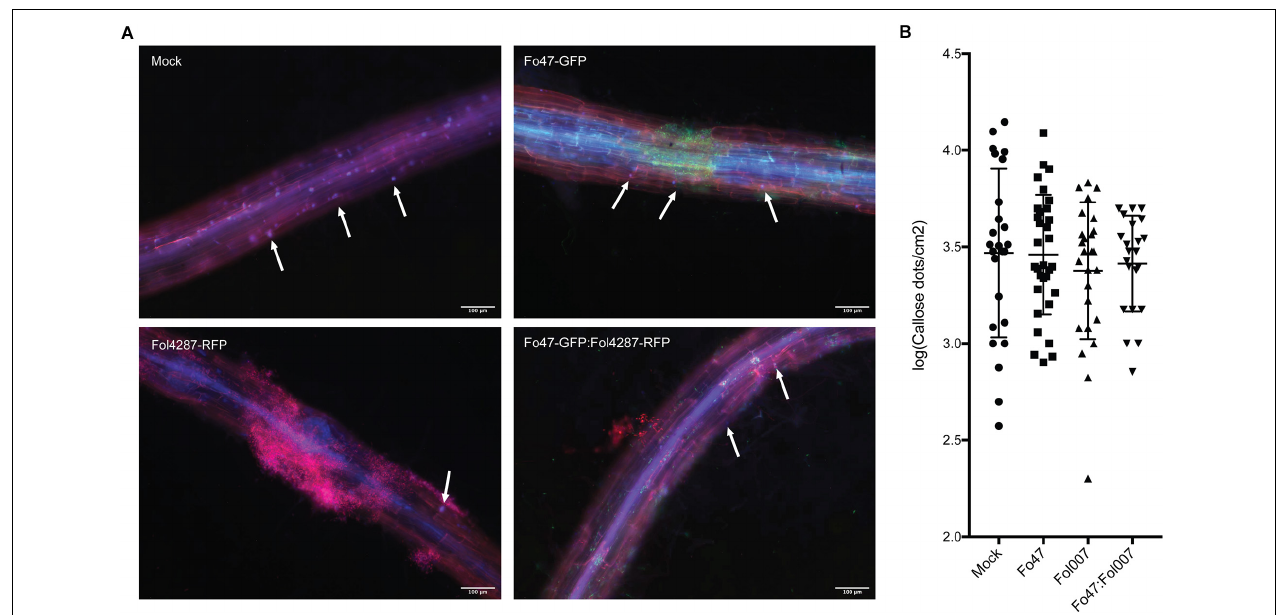
FIGURE 6 | Callose deposition in response to fungal colonization. (A) Ten days old C-32 tomato seedlings were inoculated with water (mock), Fo47-GFP, Fol4287-RFP or co-inoculated with Fo47-GFP and Fol4287-RFP. Three days after inoculation tomato roots were stained with aniline blue, and callose depositions were analyzed using a Digital Inverted Fluorescence EVOS Microscope (magnification 10 × ). Scale bar = 100 µ m. Arrow heads point to callose depositions. (B) Ten days old C-32 tomato seedlings were inoculated with water (mock), Fo47-RFP, Fol007-GFP or co-inoculated. Quantification of the number of callose dots per root area as determined using the Image J Fiji plugin. A minimum four plants per treatment were analyzed using at least three pictures per plant. Data was normalized by log transformation and for statistical analysis an ANOVA test was performed. The experiment was performed thrice with similar